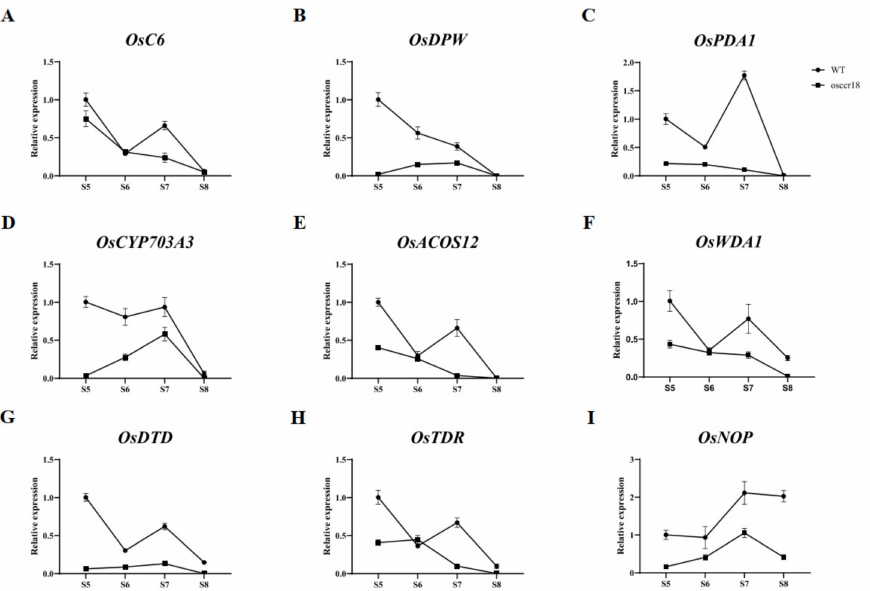
Figure 5. Expression analysis of the tapetum programmed cell death (PCD) – related genes in WT and osccr18 mutants. The experiments were performed with three biological replicates and three technical replicates. Data are shown as the means ± SD ( n =